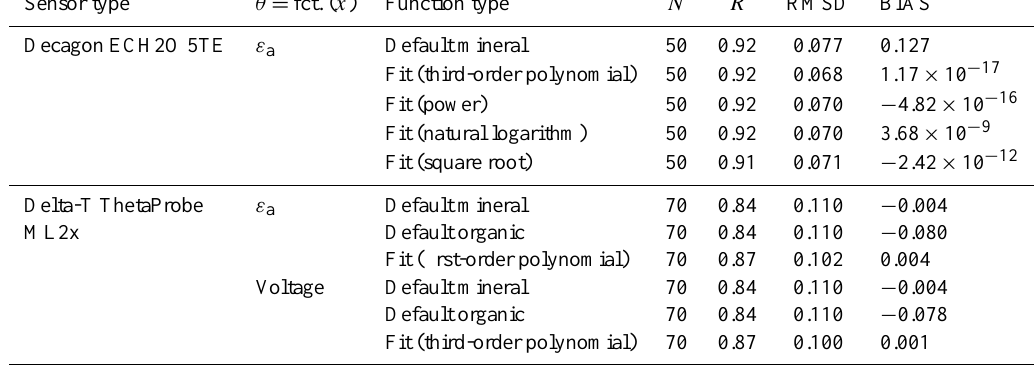
Table 5. Statistics for manufacturer’s default calibration curves and functions fitted through the data measured in organic layers (SOM > 30%) as listed in Table 4 for Decagon 5TE ( θ = fct. ( ε a )) and Delta-T ThetaProbe ( θ = fct. ( ε a ) and θ = fct. (voltage)), respec- tively: N is the number of sampling points, R is Pearson’s correlation coefficient, RMSD is bias-corrected root mean square deviation, BIAS is bias, θ is volumetric moisture content, ε a is apparent relative permittivity.